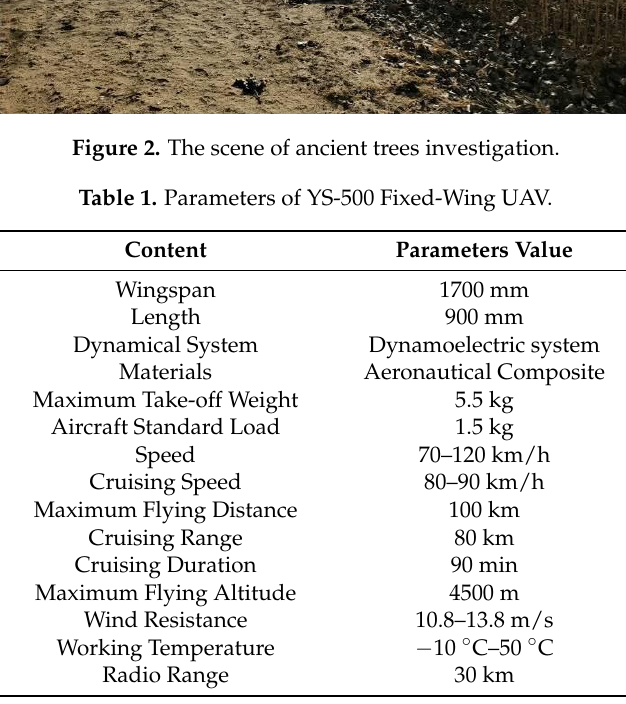
Figure 3. YS-500 Fixed-Wing Unmanned Aerial Vehicle (UAV).